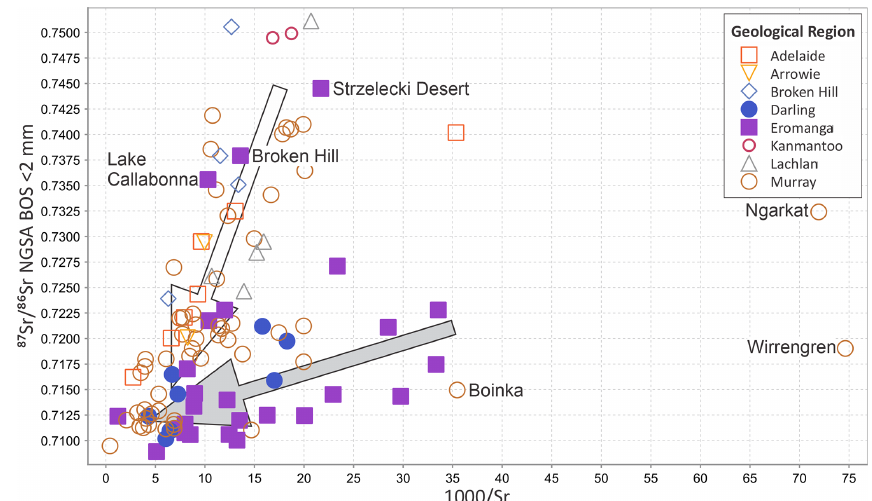
Figure 6. Scatterplot of 87 Sr / 86 Sr vs. 1000 / Sr in the NGSA BOS < 2mm samples from the Darling–Curnamona–Delamerian (DCD) Sr isotope study area, grouped by main geological region each catchment is